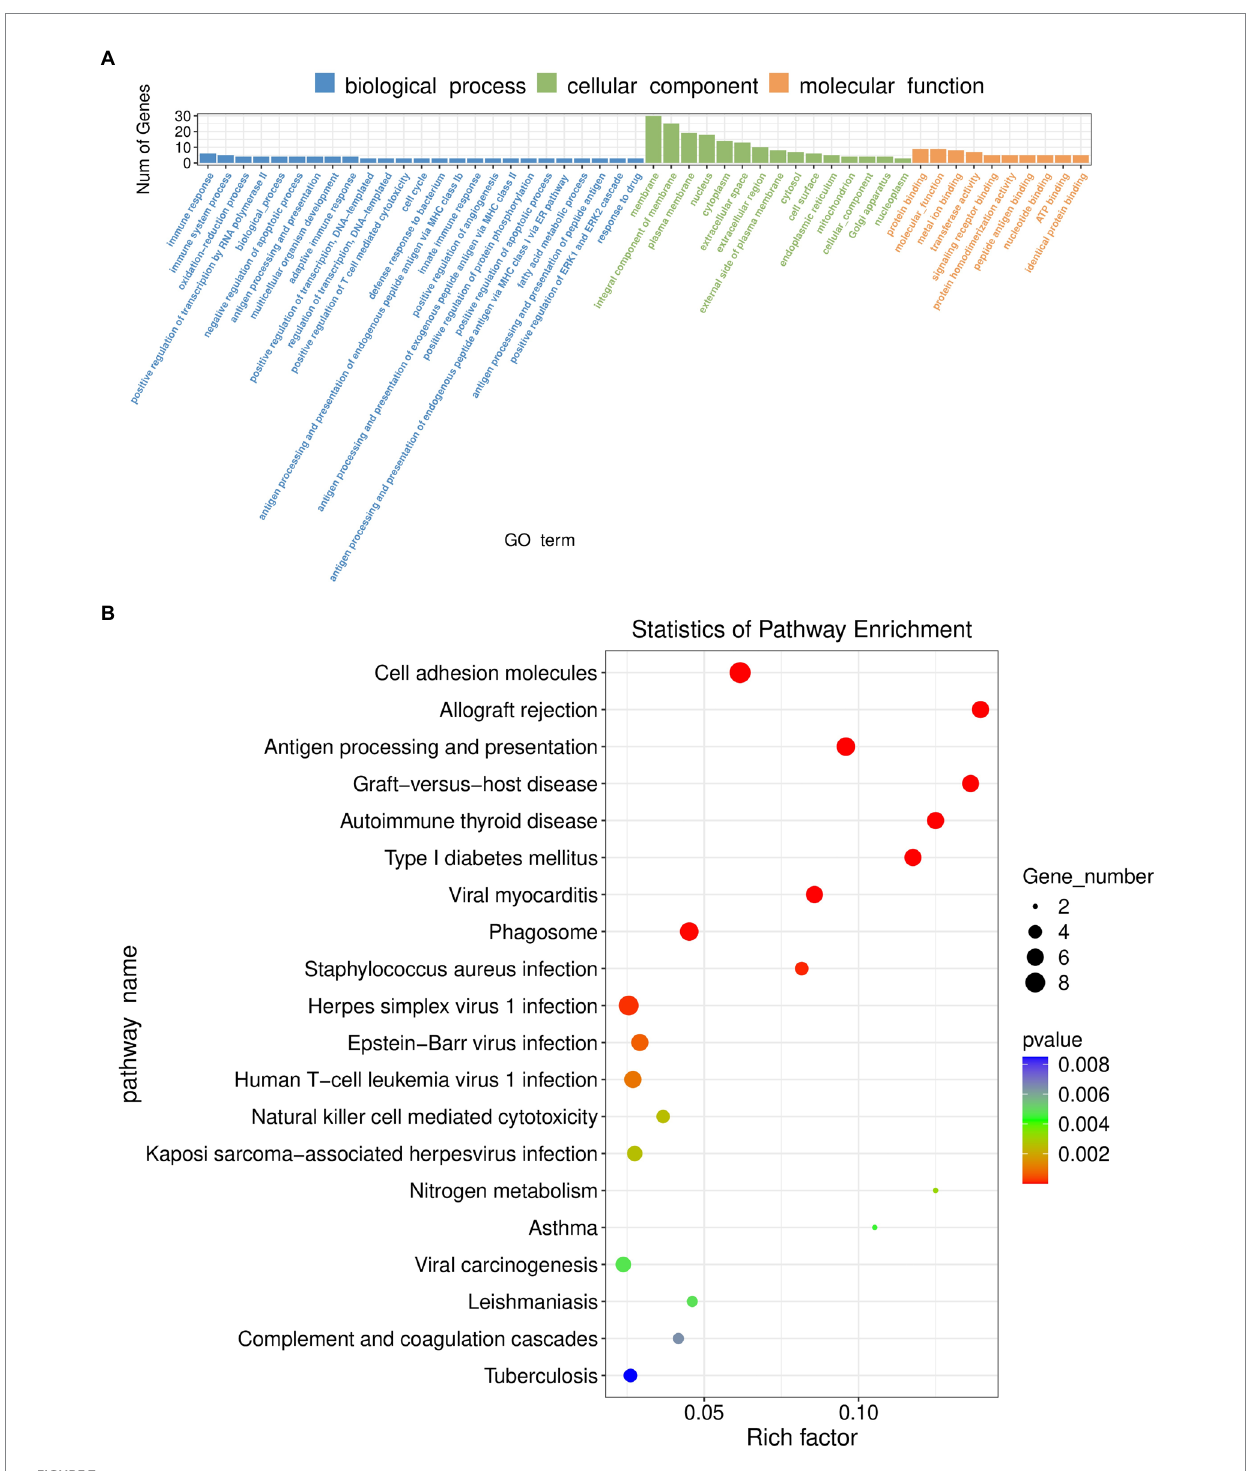
FIGURE 7 (A) GO enrichment classification histogram in transcriptomics. (B) KEGG enrichment analysis bubble plot in